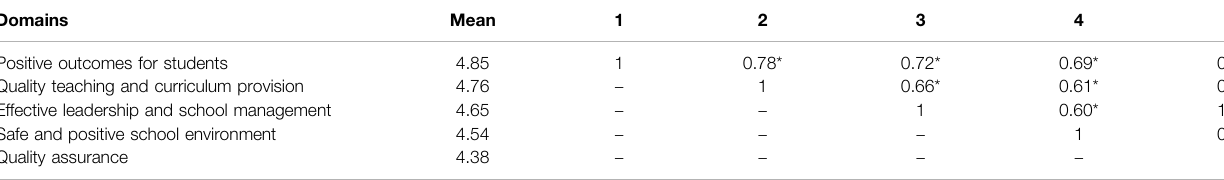
TABLE 3 | Mean and Bivariate Correlation of Variables.